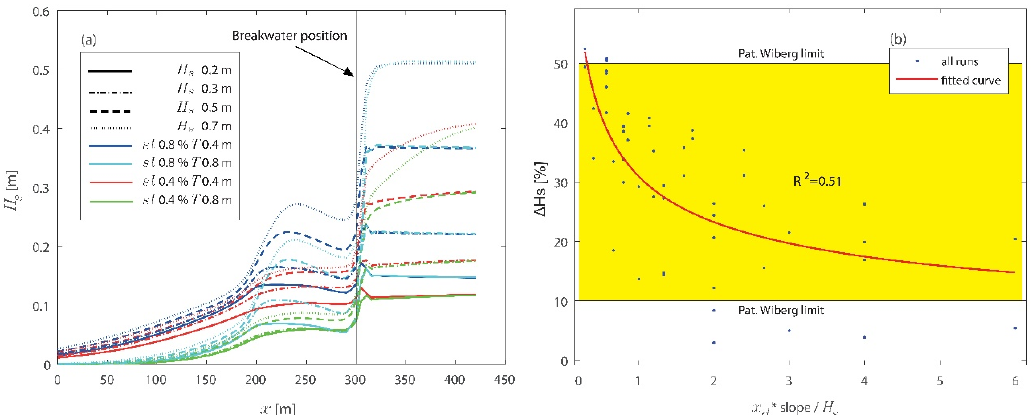
Figure 2. ( a ) Example of wave damping for the x d = 100 m configuration. Type of line changes according to the wave height, the color is relative to slope and tide. Red continuous line represents ( H s = 0.2 sl = 0.4% T = 0.4), blue continuous ( H s = 0.2 sl = 0.8% T = 0.4), cyan dashed ( H s = 0.5 sl = 0.8% T = 0.8), and so on. ( b ) Wave damping for all runs as function of the dimensionless variable x d *slope/ H s . Wiberg limits define the range within she measured waves damping, which are consistent with our model results.